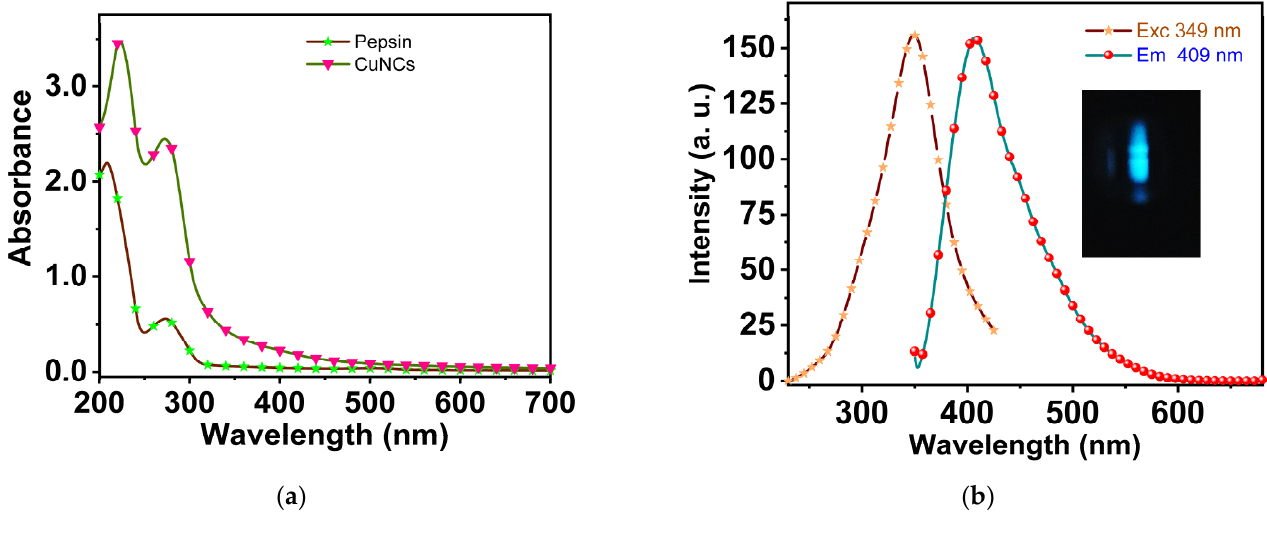
Figure 1. ( a ) The absorption spectra of pepsin and Pep-CuNCs; ( b ) The excitation and emission spectra of Pep-CuNCs.